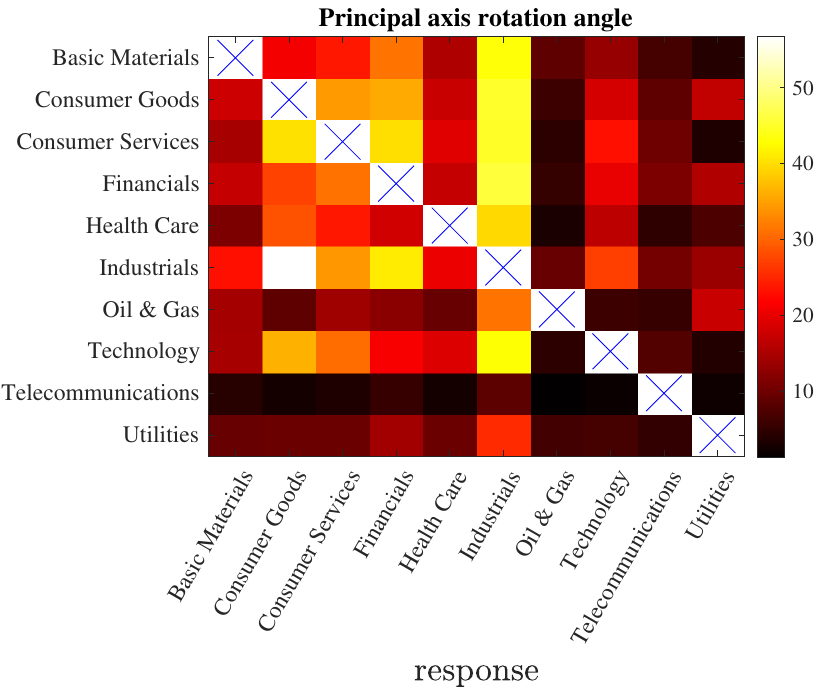
Figure 5. Angles of rotation, Θ X → Y , of the principal axes as consequence of conditioning (degrees). The rows are the conditioning variables and the columns the conditioned